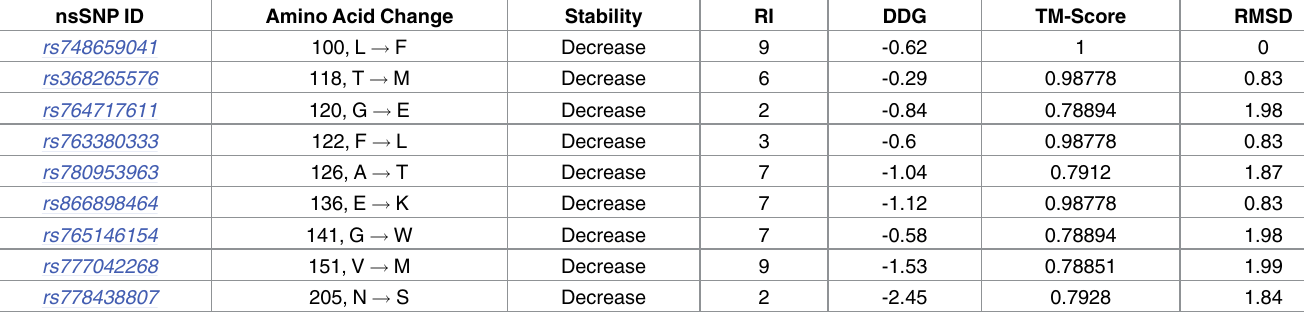
Table 3. I-MUTANT 2.0 and TM-align predictions for nsSNPs in RhoGAP domain of TAGAP . nsSNP ID Amino Acid Change